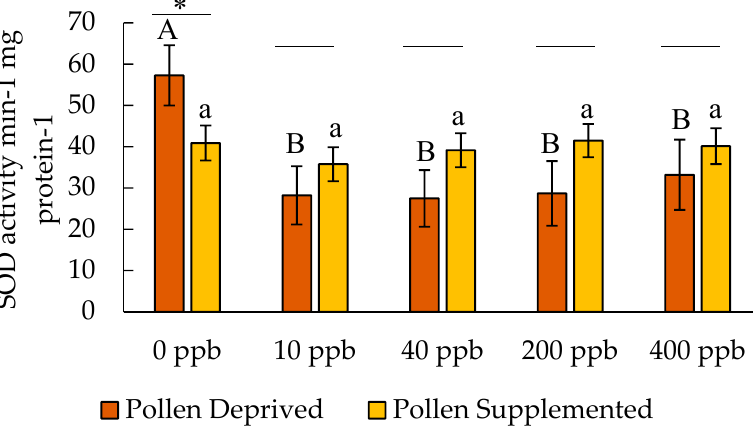
Figure 2. Activity of superoxide dismutase in adult honey bees after clothianidin exposure (mean ± SE). Letters indicate significant differences between doses within a feeding treatment, and * indicates a significant difference between feeding treatments for a particular dose.